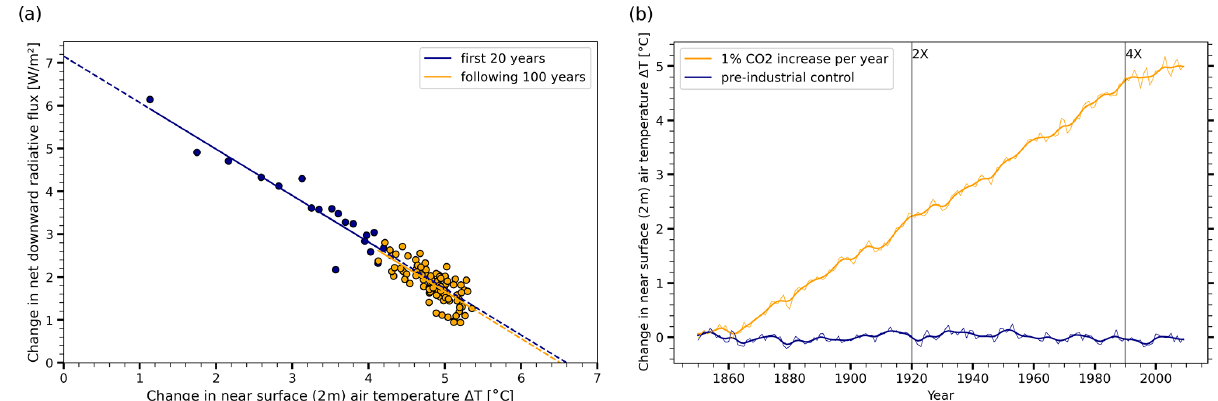
Figure 13. (a) Gregory regression plot from the abrupt 4xCO2 experiment in comparison to the pre-industrial control. We construct the linear regression of near-surface (2m) air temperature change ( (cid:49)T ) against the downward net radiative flux change ( (cid:49)F ). From its axis intersection points we obtain the radiative forcing (cid:49)F = 7 . 06Wm − 2 , and the equilibrium temperature difference (cid:49)T = 6 . 49 ◦ C. The climate response = 0 . 92 KW − 1 , and the equilibrium climate sensitivity ECS = (cid:49)T = 3 . 24 ◦ C. The first 20 years parameter of AWI-CM3 is then α = (cid:49)T (cid:49)F 2 already results in a linear regression almost identical to the following 100 years. (b) As Fig. 10b but for the experiment with a 1% increase in CO 2 per year. Vertical lines indicate doubling and quadrupling of CO 2 concentrations. The estimated transient climate response is 2.1 ◦ C. Table 2. Computational performance optimized for integration speed. Simulated years per day (SYPD) and core hours per simulated year (CHSY) of AWI-CM3 for three atmospheric grids, two ocean meshes, and two IO schemes are shown. Values were measured on HPC system JUWELS (at Jülich Supercomputing Centre) with Intel Xeon Platinum 8168 CPU, 2 × 24 cores, and 2.7GHz processors, accepting sub-linear strong scaling. The atmospheric grids TCo95L91, TCo159L91, and TCo319L137 have a grid point resolution of 100, 61, and 31km and 91, 91, and 137 vertical layers, respectively. The CORE2 mesh (Fig. 2a) has 47 vertical layers, ∼ 127000 surface nodes, and a peak resolution of 20km in northern middle to high latitudes and up to 125km in subtropical gyres. The horizontal resolution of the DART mesh follows the local Rossby radius, peaks at a highest resolution of 5km, and has a maximum spacing of 27km, with ∼ 3 . 1 million surface nodes and 80 vertical layers. Atmosphere grid Ocean